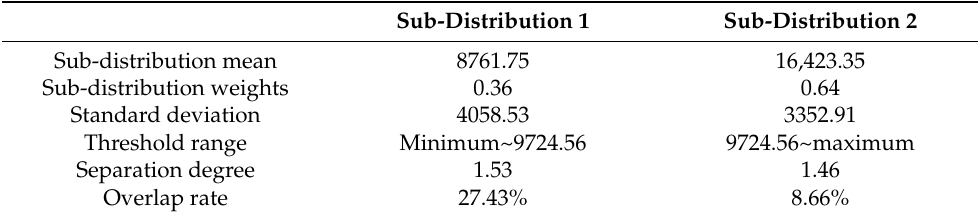
Table 6. Parameter values of each sub-distribution of the improved mixed monolithic sieving model for image